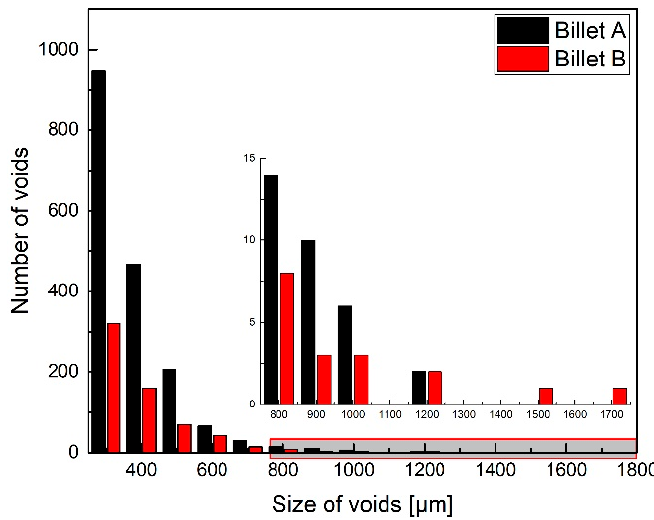
Figure 5. Size distribution of micro-voids in billets.